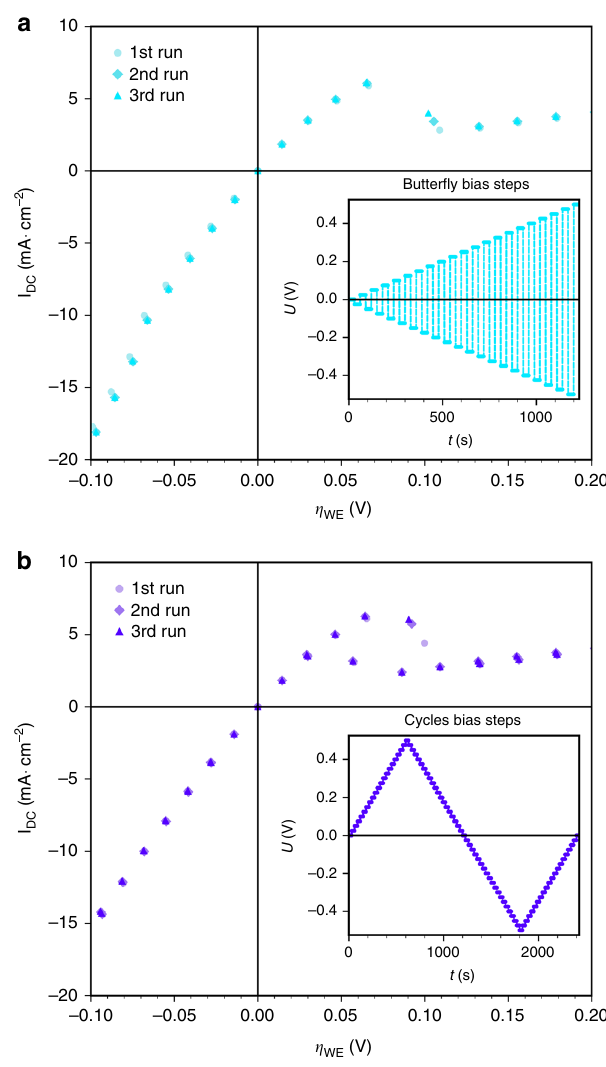
Fig. 7 Current density versus overpotential curves measured in the lab on a post-exsolved sample — i.e., after in-situ experiments. Error bars (con fi dence intervals) of overpotential and current are smaller than the symbols. a Result with voltage program Butter fl y. b Result with voltage program Cycles. Both voltage programs are sketched as inset in the respective